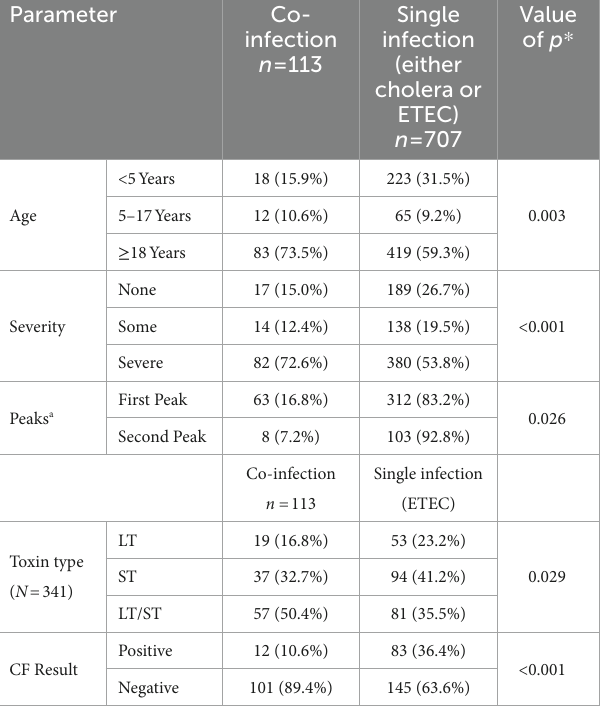
TABLE 2 Distribution of co-infection among either cholera or ETEC positive patients.